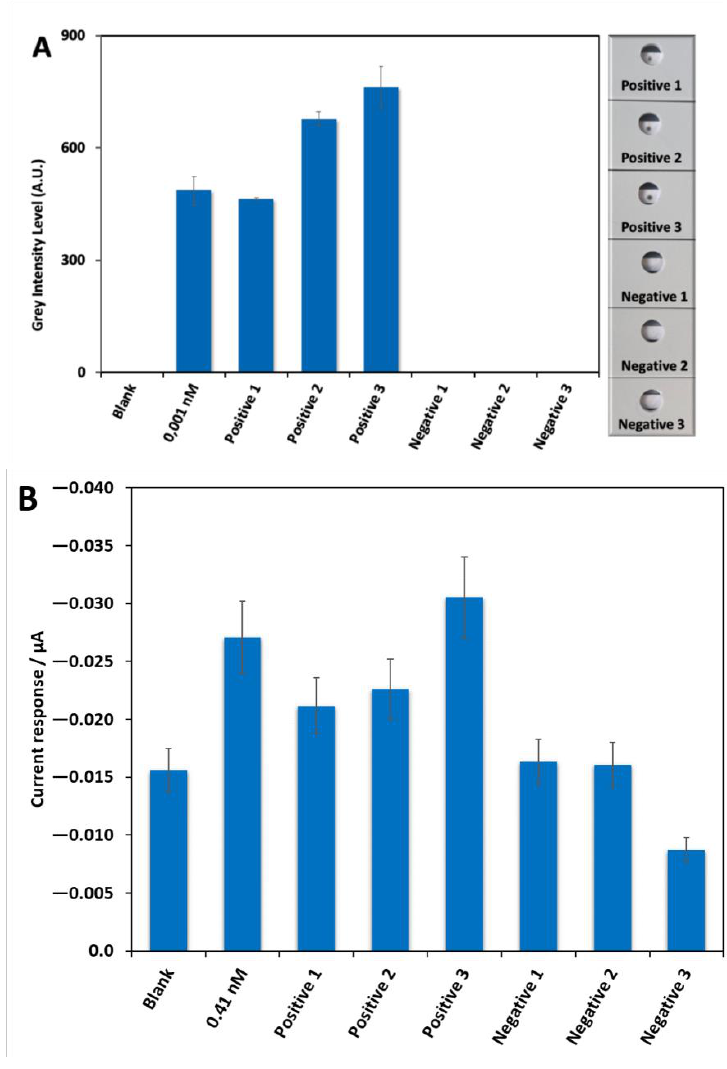
Figure 9. Testing of six real samples provided by the Biobank of the Aragon Health System (3 neg- atives and 3 positives by PCR: sample #1, Ct 35; sample #2, Ct 19 and sample #3, Ct 30) in UTM from Biocomma with the PPRH-CC1 as capture sequence using the two developed biosensor devices. ( A ): Profile of ipeak ® (IUL S.A. commercial lateral flow reader) quantification (grey intensity level measurements, right side) of the results obtained with the TLF together with the signal obtained for the blank and control of 0.001 nM of target DNA CC1 sequence and the image obtained from the back part of the LF strips (thermosensitive material, left side) after the laser irradiation using a 1064 nm laser used. This image was used to measure the grey level intensity to develop the results of the thermal lateral flow assay. ( B ) Analytical signal values obtained by the electrochemical biosensor platform, together with the signal obtained for the blank and control of 0.41 nM of target DNA CC1 sequence. Standard deviation of three replicates carried out consecutively is drawn as error